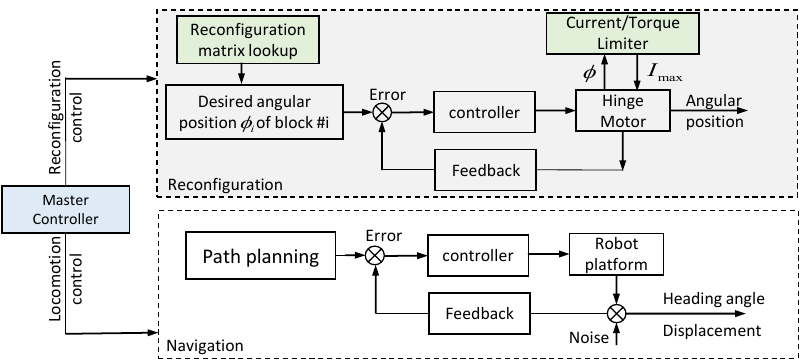
Figure 14. Schematic of control for hTetro incorporating reconfiguration matrix lookup table and the current/torque